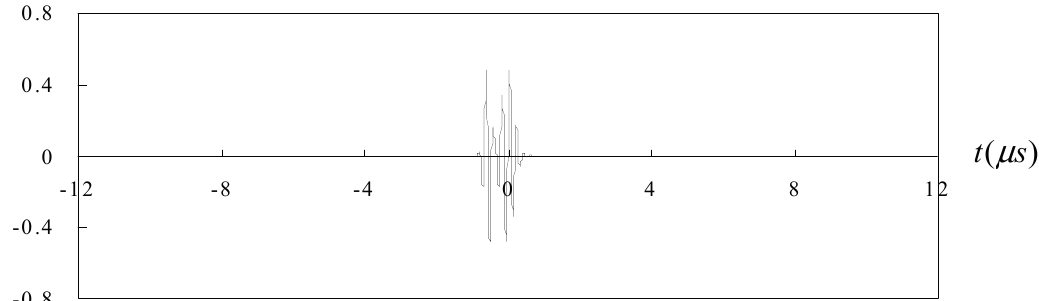
Figure 7. Two pulses with time delay